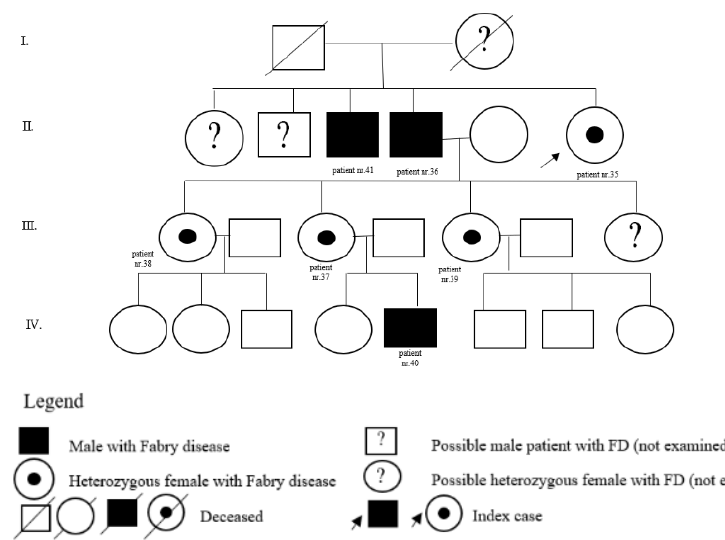
Figure 7. Pedigree of family with GVUS c.427G>A (p.Ala143Thr).